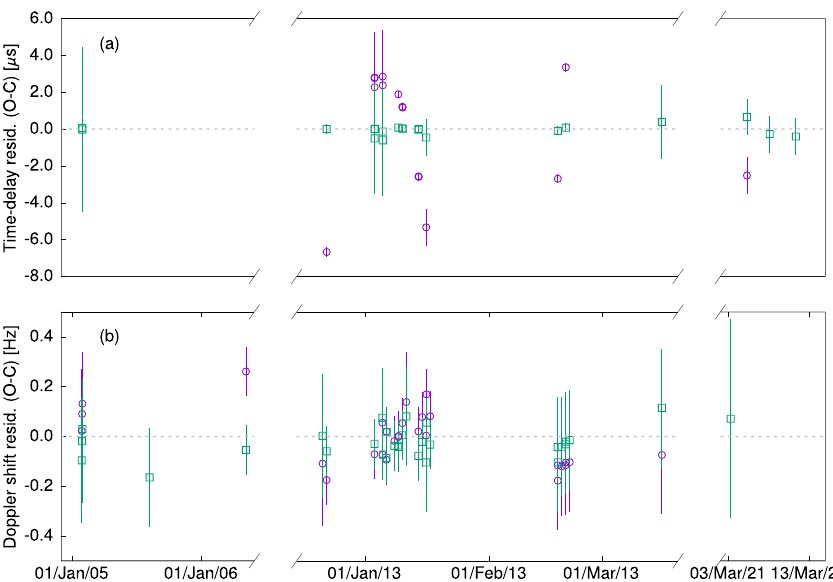
Fig. 2 Goldstone and Arecibo radar astrometry residuals in time. a Time-delay and b Doppler-shift residuals. Purple circles correspond to the gravity-only solution, while green squares correspond to the non-gravitational solution. The horizontal axis corresponds to the observation date; notice that it has a different scale in each segment of the plot. Error bars represent observational uncertainties. The residuals corresponding to the non-gravitational solution, together with their uncertainties, are compatible with zero; this is not the case for all gravity-only residuals.